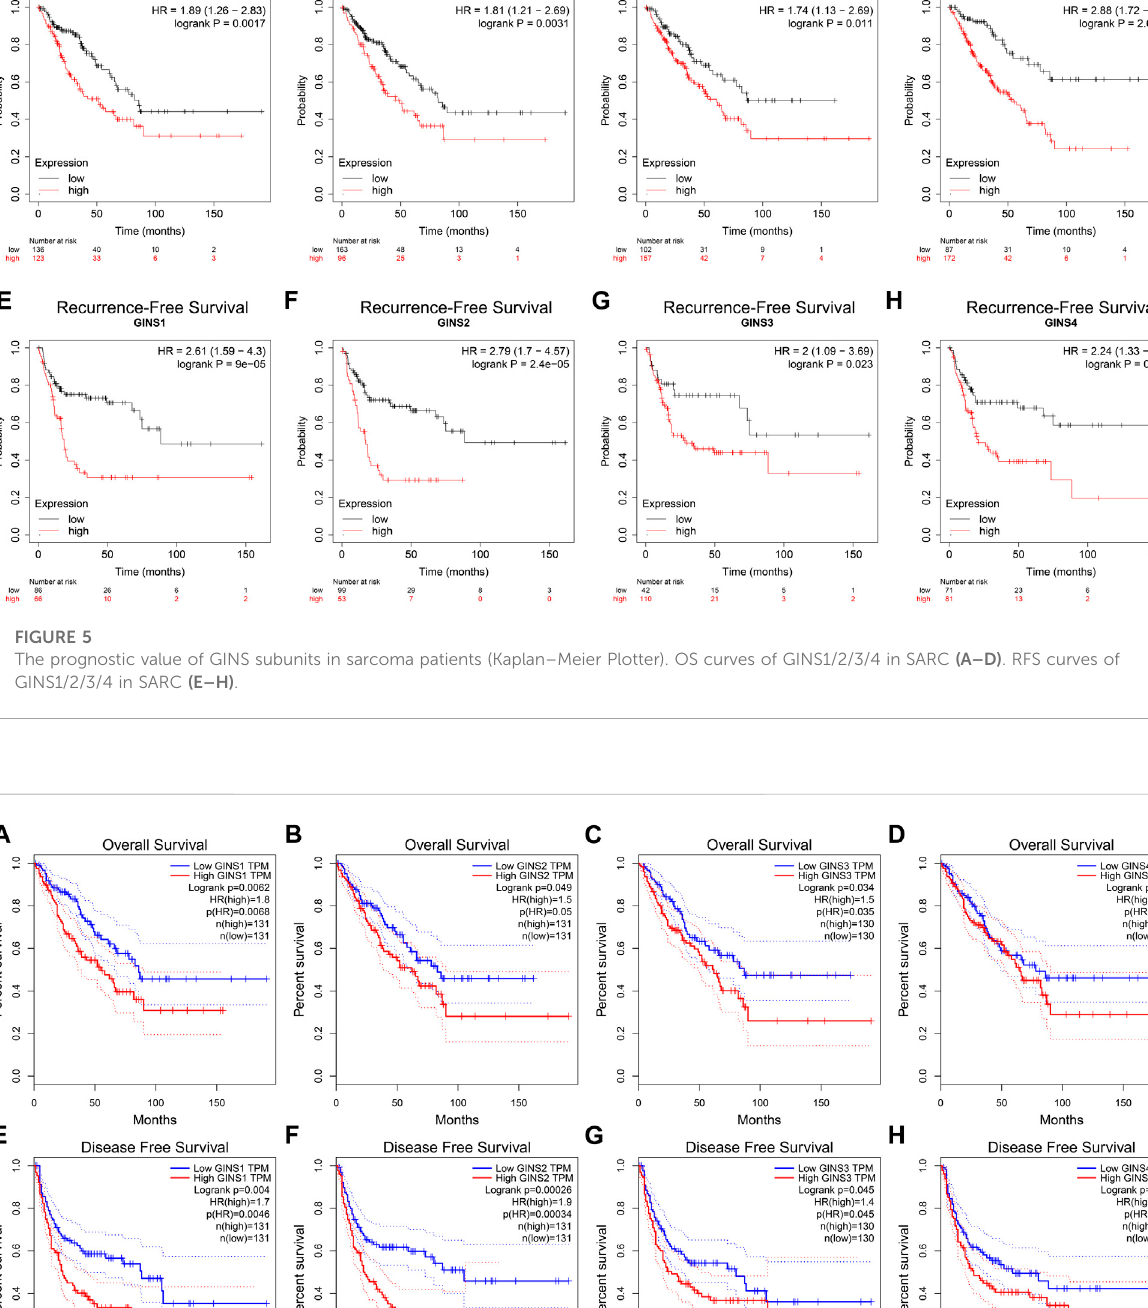
Frontiers in Cell and Developmental